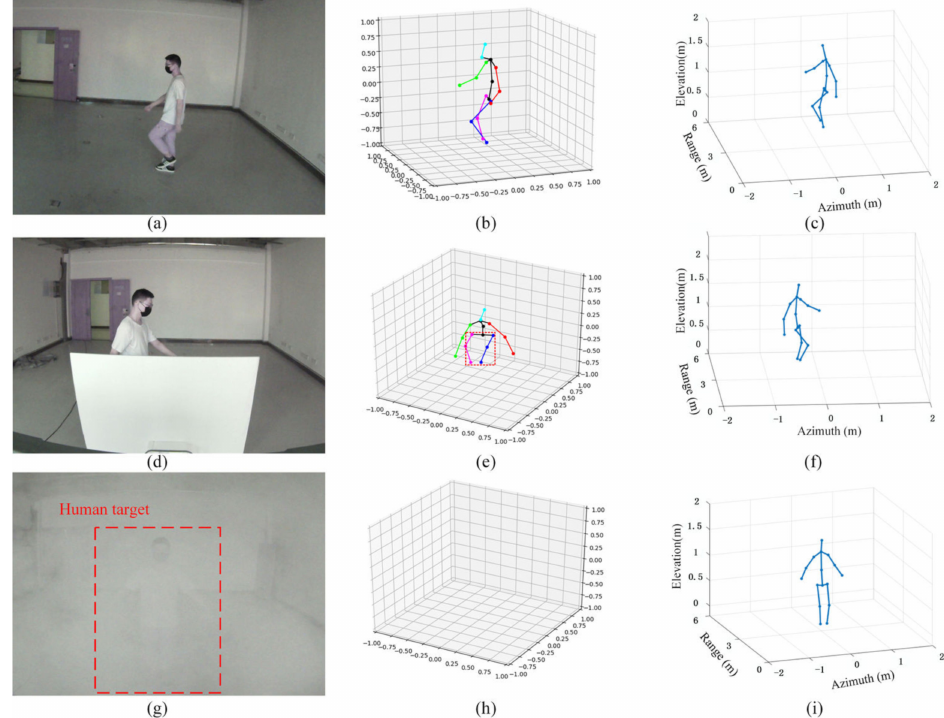
Figure 16. Comparison with the optical sensor. ( a , d , g ) The optical images captured by camera; ( b , e , h ) The 3D poses predicted by [19]; ( c , f , i ) The 3D poses reconstructed by our